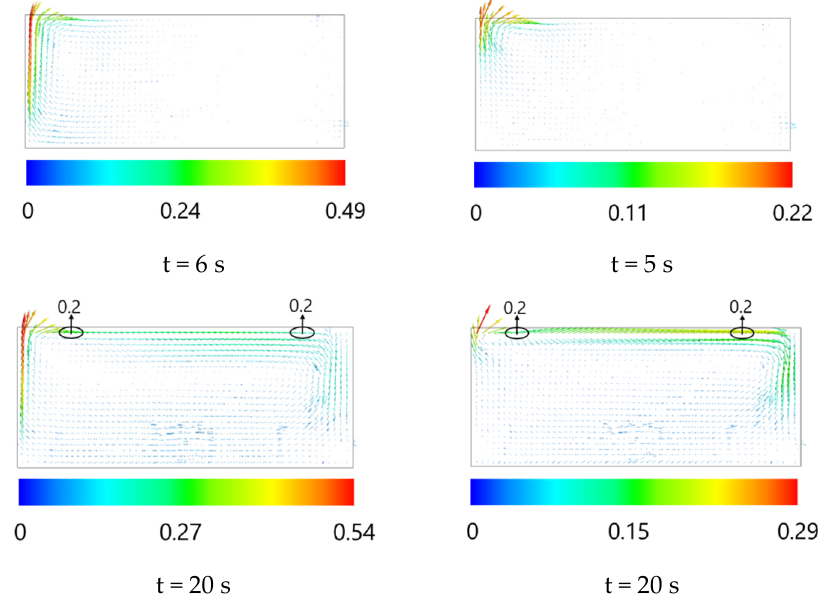
Figure 9. Velocity vectors for Model 4 (left) and Model 5 (right) whilst the envelope of 1% mole fraction of hydrogen was rising to the ceiling (up) and filling the whole ceiling (down) (m/s).